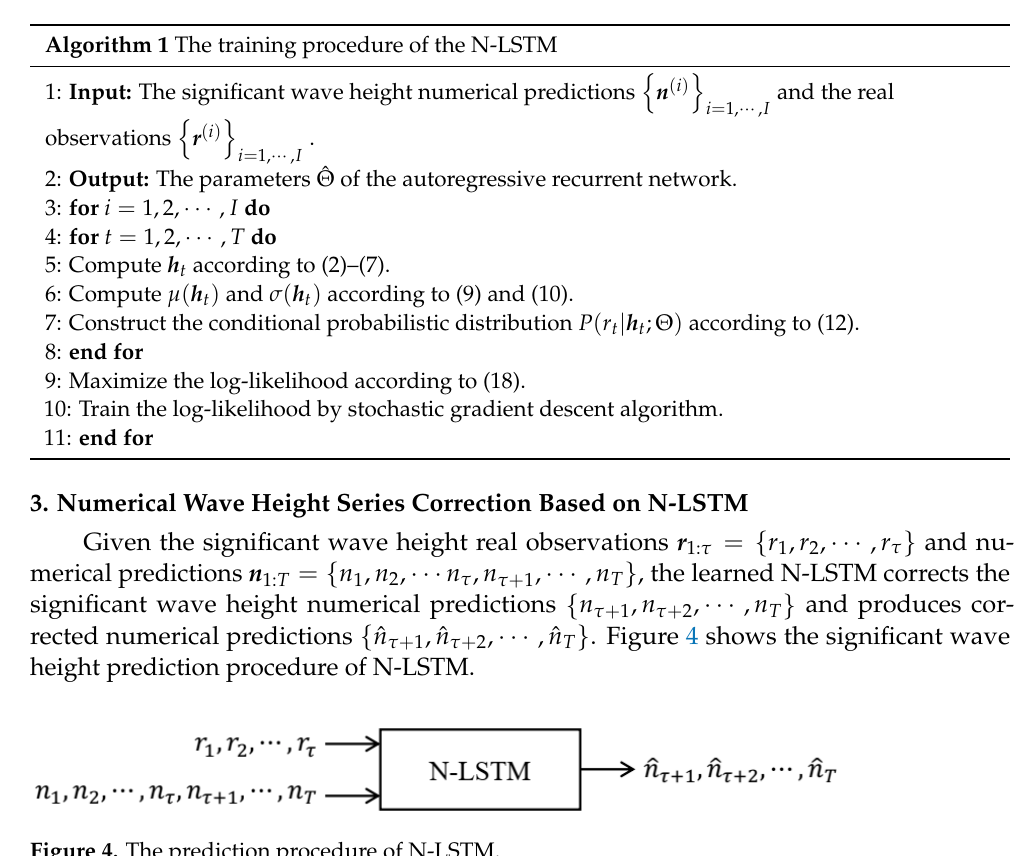
Figure 4. The prediction procedure of N-LSTM.